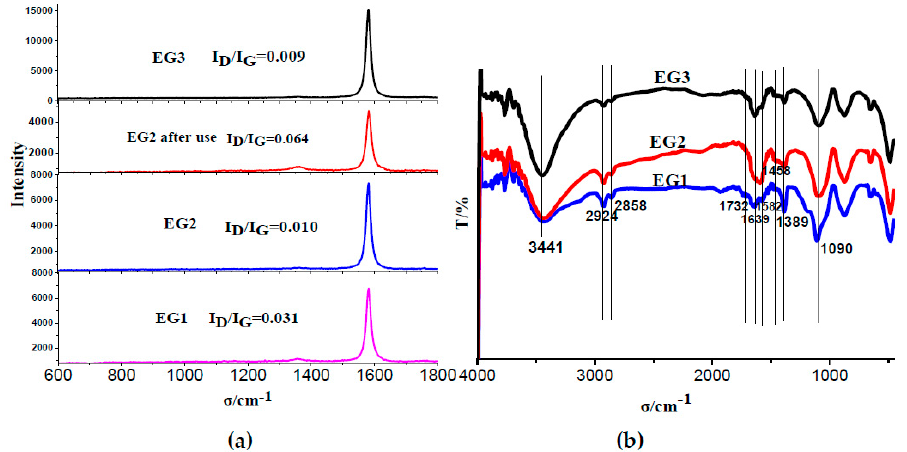
Figure 1. ( a ) Raman spectra and ( b ) The Fourier transform infrared (FTIR) spectra of expanded graphite (EG).